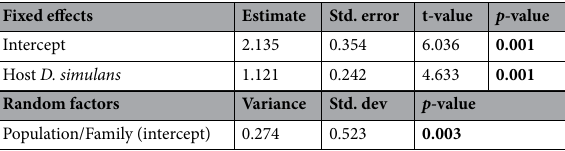
Table 2. Fat synthesis is induced plastically based on host fat content. We analysed the data presented in Fig. 1 in the main text statistically by means of a linear mixed effects model (GLMM, lme4 package 69 ) with host (lean D. simulans and fat D. melanogaster ) and experiment (this experiment was conducted twice) as fixed effects, and family nested within population (Japan, United Kingdom 1 and 2, Belgium 1 and 2) as random effect. The percentage of incorporation of stable isotopes was used as dependent variable (n = 138), where % incorporation was summed for all fatty acids. The non-significant term experiment was sequentially removed from the model to obtain the minimal adequate model as reported in the table. Significant terms are highlighted in bold. When referring to “families,” we are referring to the comparison of daughters of singly inseminated females, which (in these haplodiploid insects) share 75% of their genome.